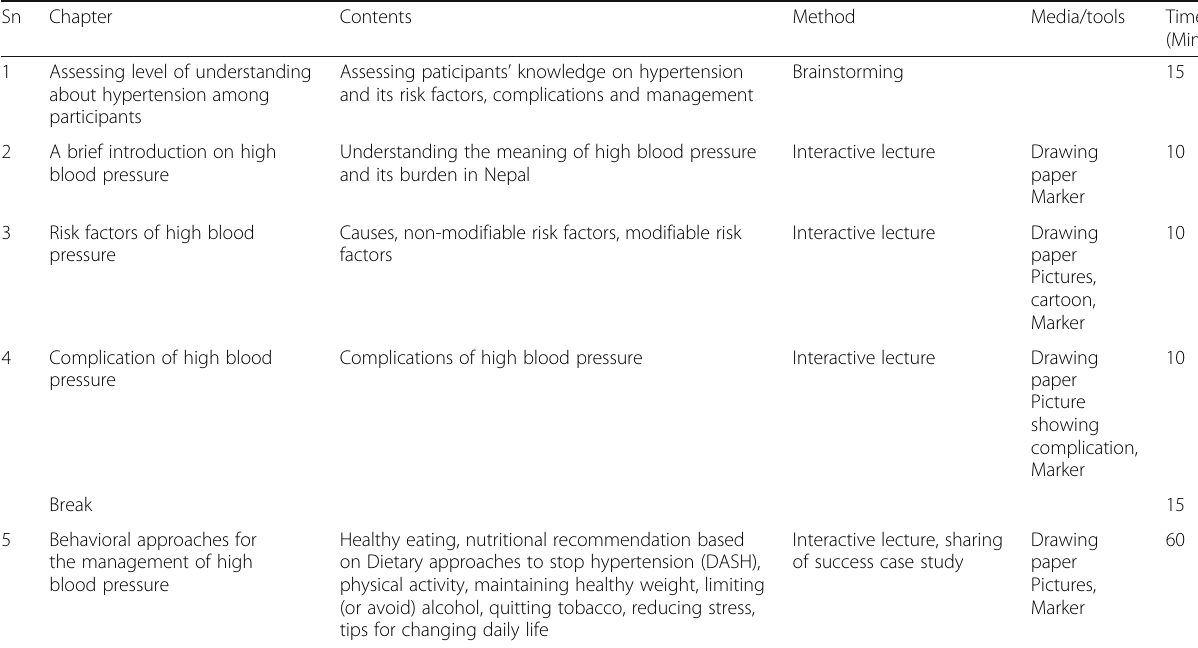
Table 2 Health education module for the study